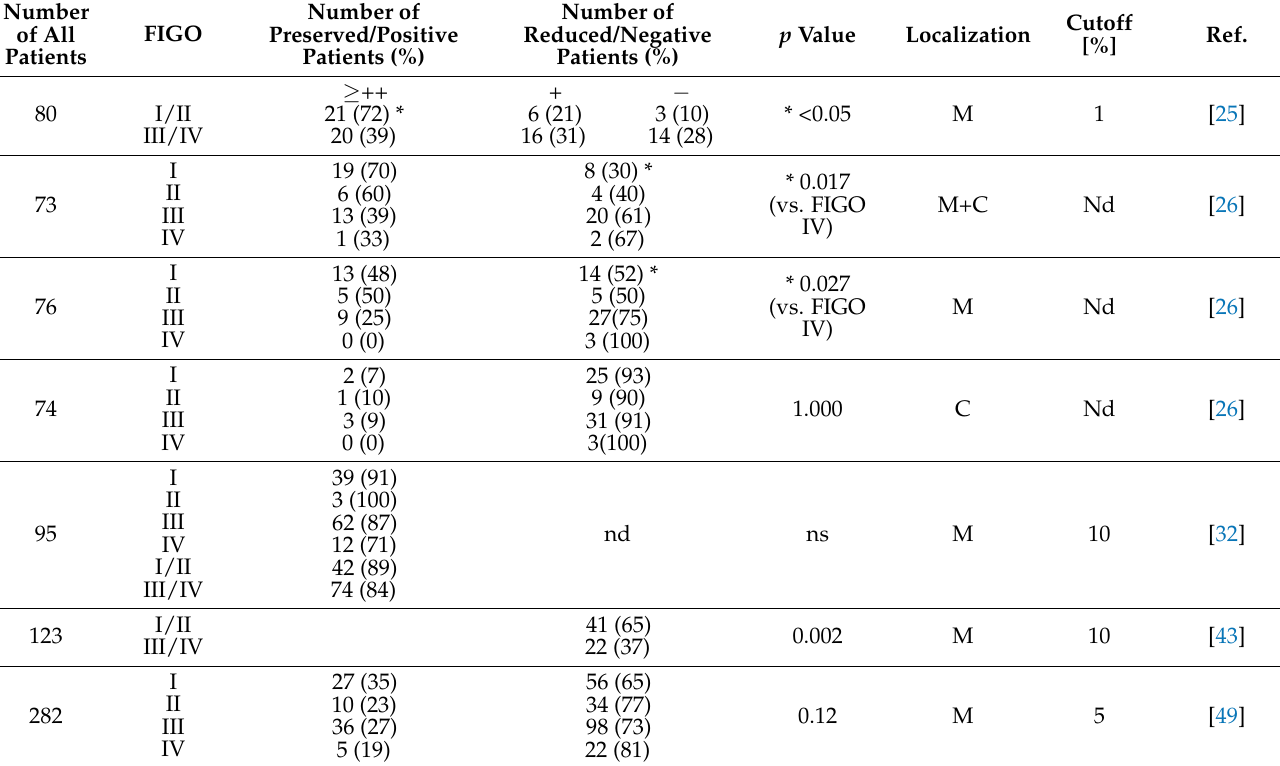
Table 2. The association of E-cadherin expression with FIGO stage of EOC patients. Number of Number of FIGO p Value Preserved/Positive Reduced/Negative Patients (%) Patients (%)